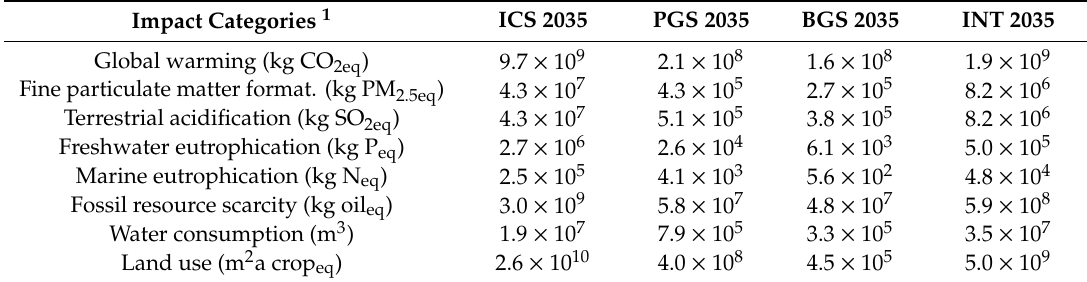
Table 5. Environmental impacts based on critical ReCiPe categories which are associated with